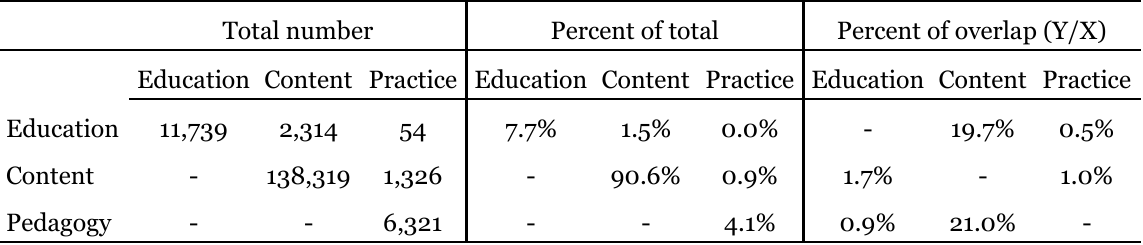
Tweet Category Frequencies and Overlaps Total